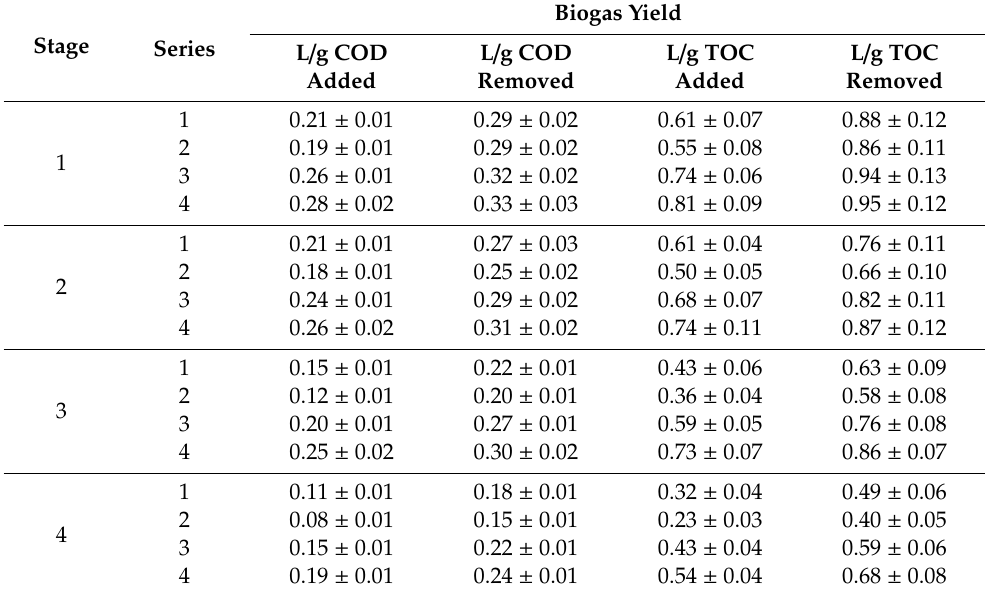
Figure 4. ( a ) Daily biogas production and ( b ) biogas composition depending on experimental stages and series. Table 4. Biogas yield obtained in experimental series.